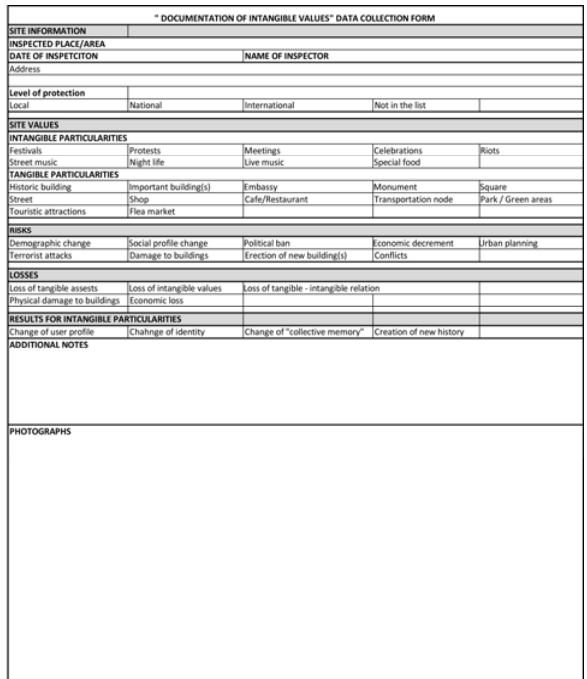
Figure 2: Blank Data Collection Form 3. CASE STUDIES: TAKSIM SQUARE, ISTANBUL